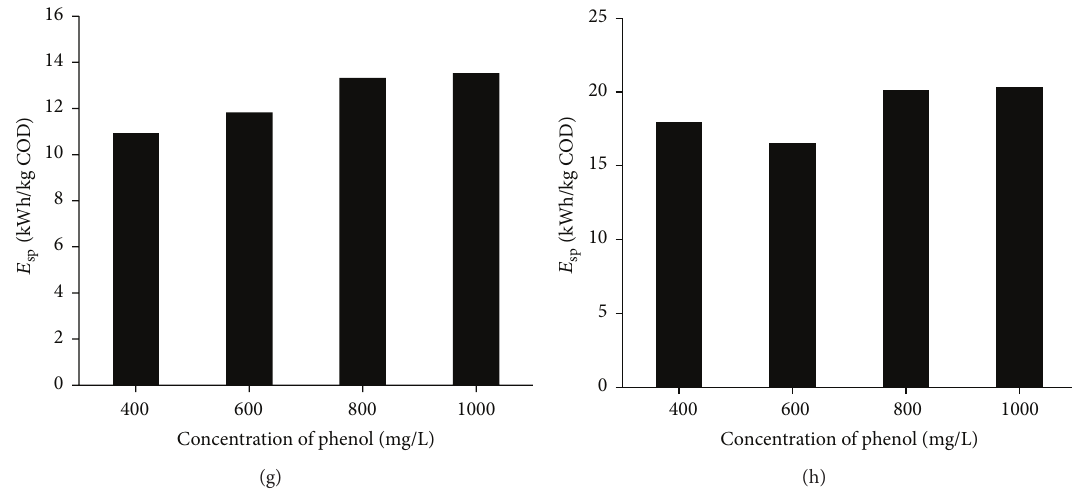
Figure 5: Variation of COD and power consumption in different initial concentration wastewater over time. (a) Variation of theoretical COD concentration over time. (b) Removal rate variation of theoretical COD in different initial concentration wastewater over time. (c) Measured COD in different initial concentration wastewater over time. (d) Removal rate variation of actual COD in different initial concentration wastewater over time. (e) Theoretical power consumption of different initial concentration wastewater treatment over time. (f) Actual power consumption of different initial concentration wastewater over time. (g) Average theoretical power consumption in different initial concentration of wastewater treatment. (h) Average actual power consumption in different initial concentration of wastewater